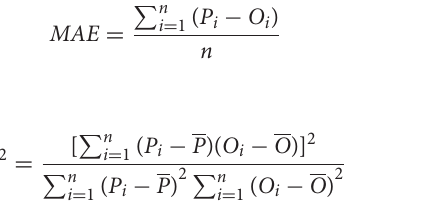
( Figure 2 ). The average daily R n , R s , T a , VPD, and RH during the nongrowing season were 3.28 MJ m − 2 , 12.65 MJ m − 2 , − 3.67 ◦ C, 0.23 kPa, and 57.16%,